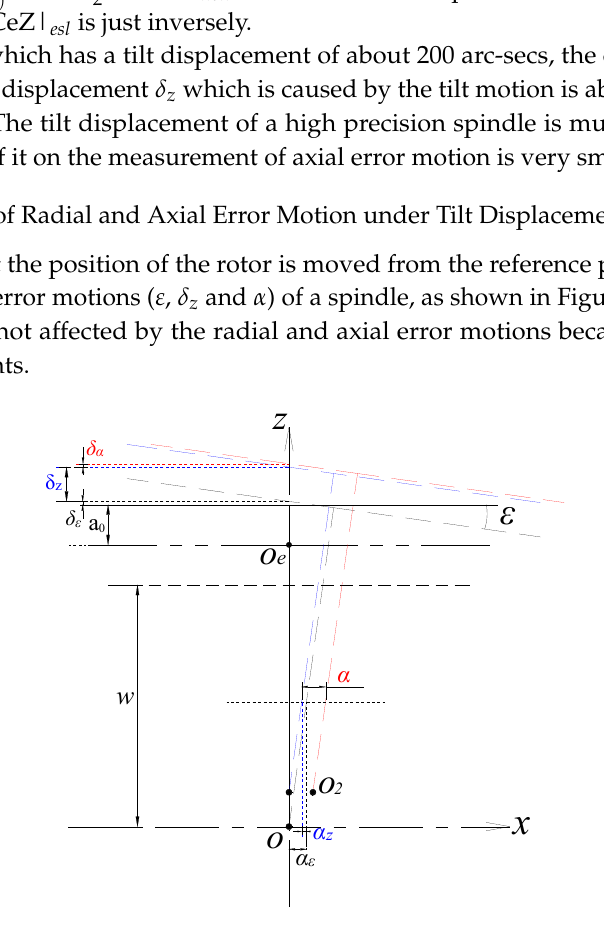
Figure 8. Schematic of the coupling effect of radial and axial error motion.